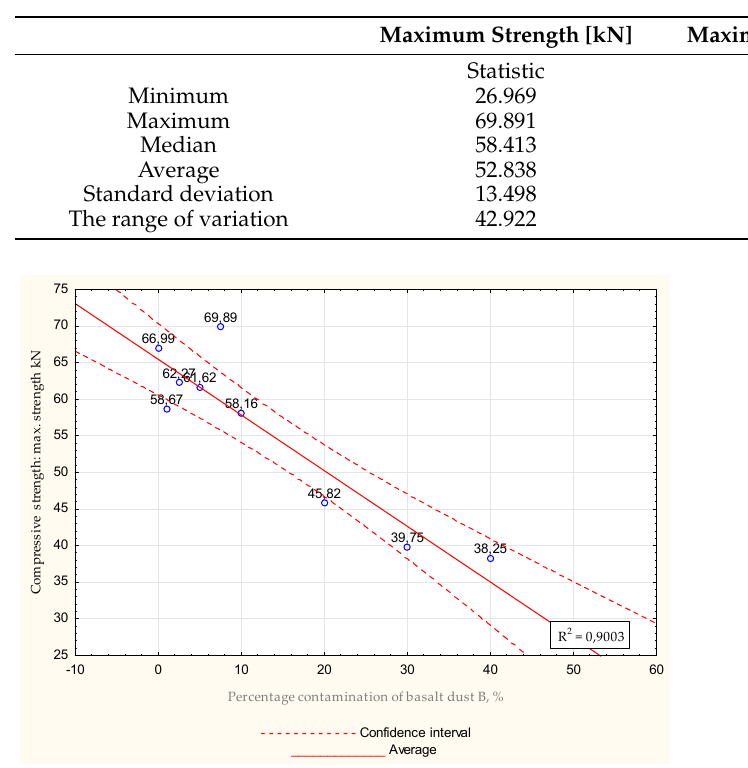
Table 18. Compressive strength tests for basalt dust B for all samples for water − mix ratio = 0.5 after 28 days.